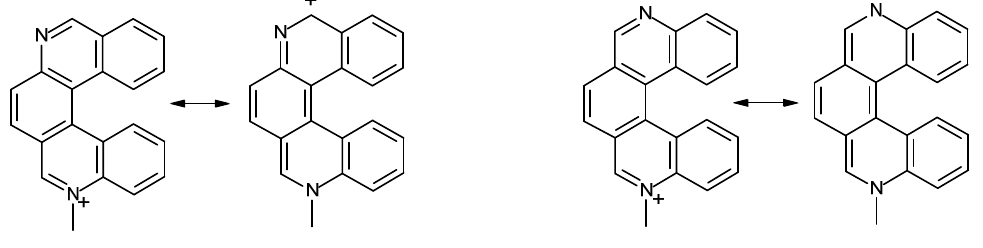
Figure 3. Limit structures of monomethylated diazahelicenes 8 and 10 showing delocalization of positive charge onto the ring bearing the unprotonated nitrogen